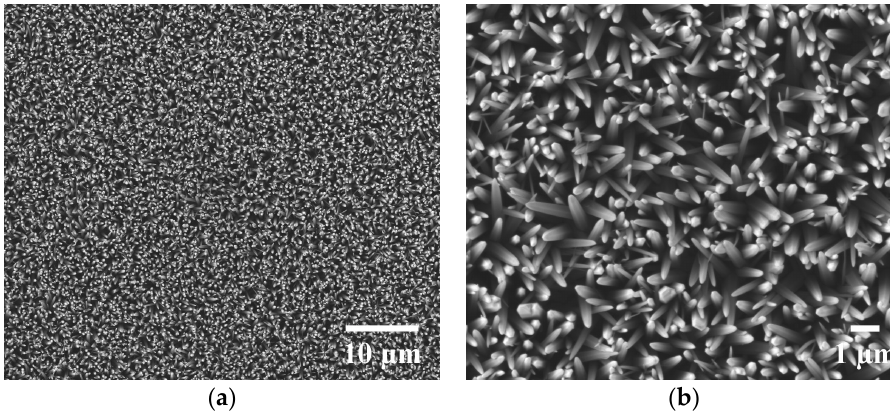
Figure 1. Scanning electron microscopy (SEM) images of zinc oxide (ZnO) nanowire arrays: ( a ) SEM image at a magnification of 2500×; ( b ) SEM image at a magnification of